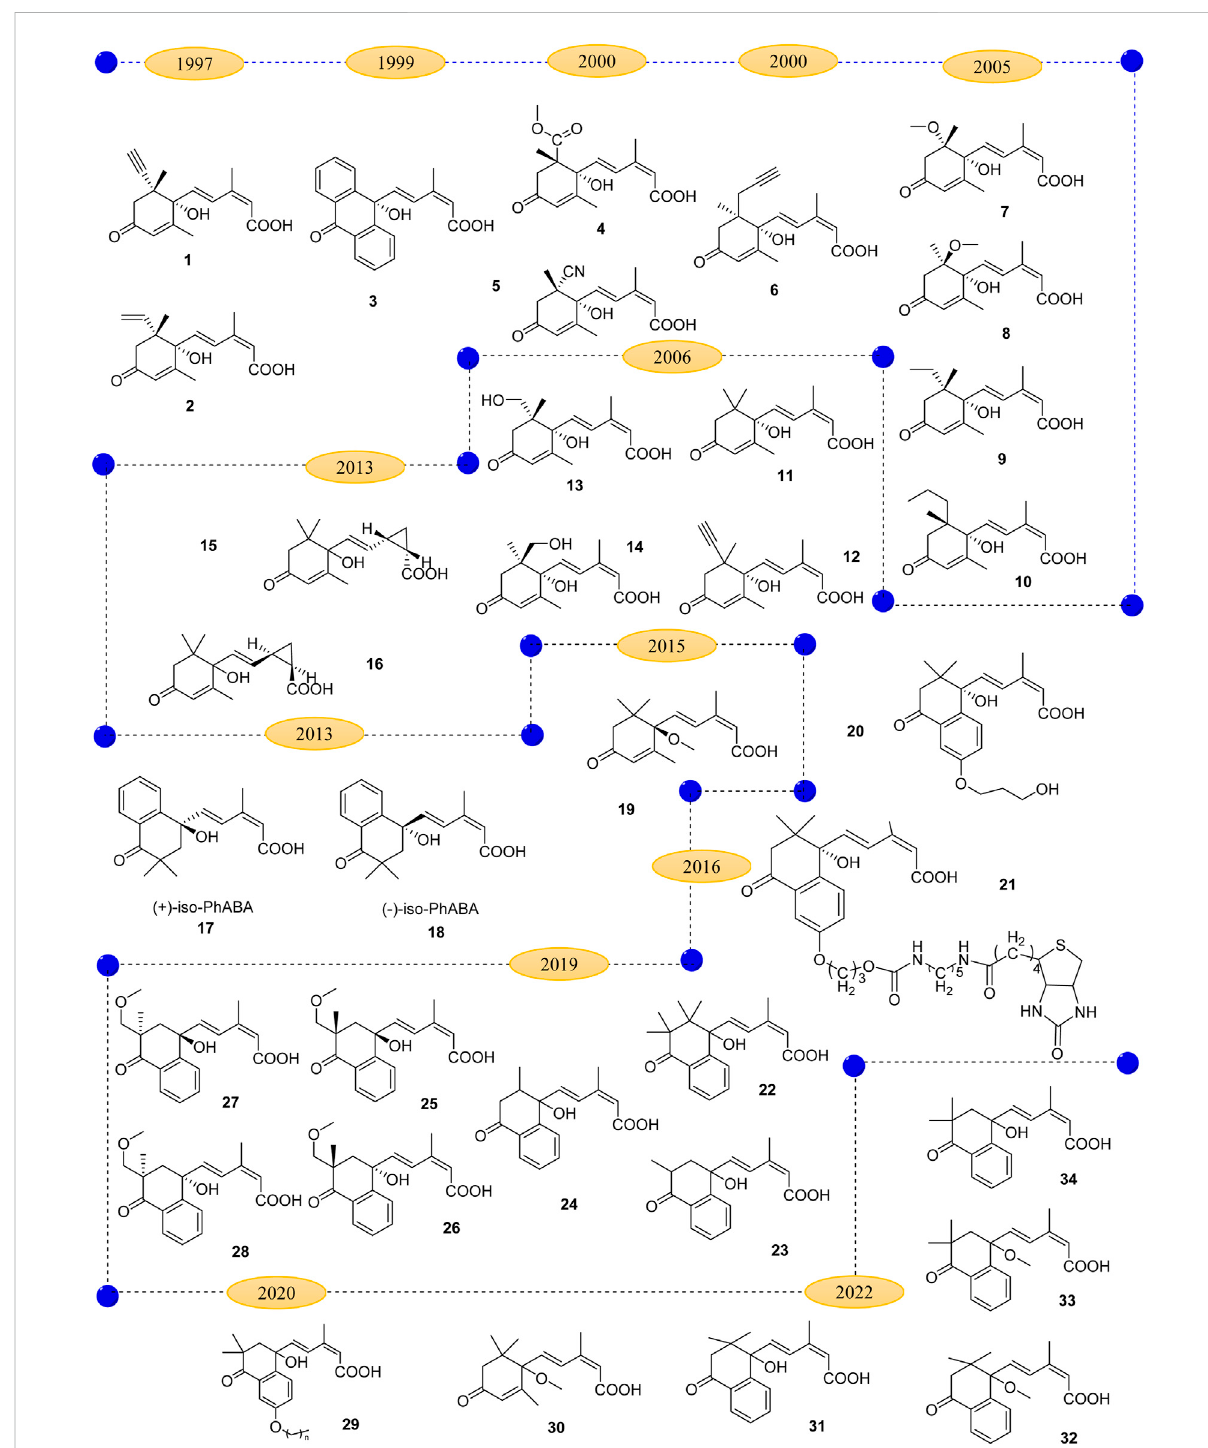
FIGURE 3 The development of abscisic acid structural